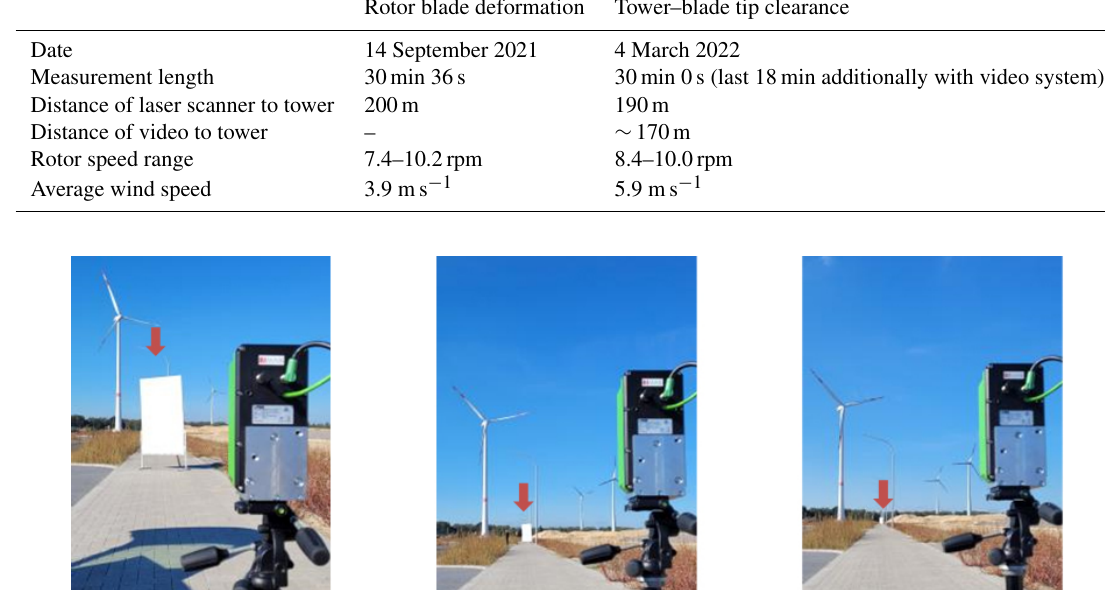
Figure 4. Whiteboard (marked with red arrow) placed at different working distances and with different angles with respect to the laser scanner. The number of scans for each position and orientation amounts to > 10000.